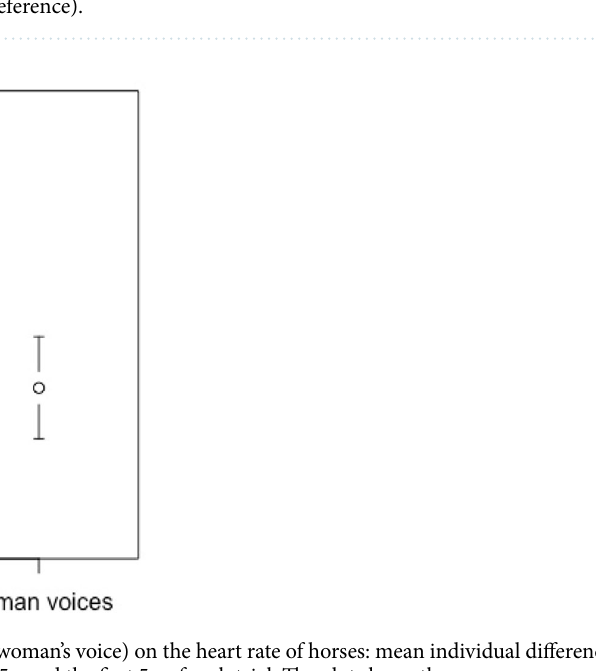
Figure 3. Mean preference index per individual: (INC − CON)/(INC + CON) for each trial. The plot shows the group mean and the confidence interval. Significance was assessed by a Student’s t test: * = P < 0.05. The arrows show the preference of the horses toward the congruent or incongruent video. The dotted line corresponds to random choices (indicating a lack of preference).